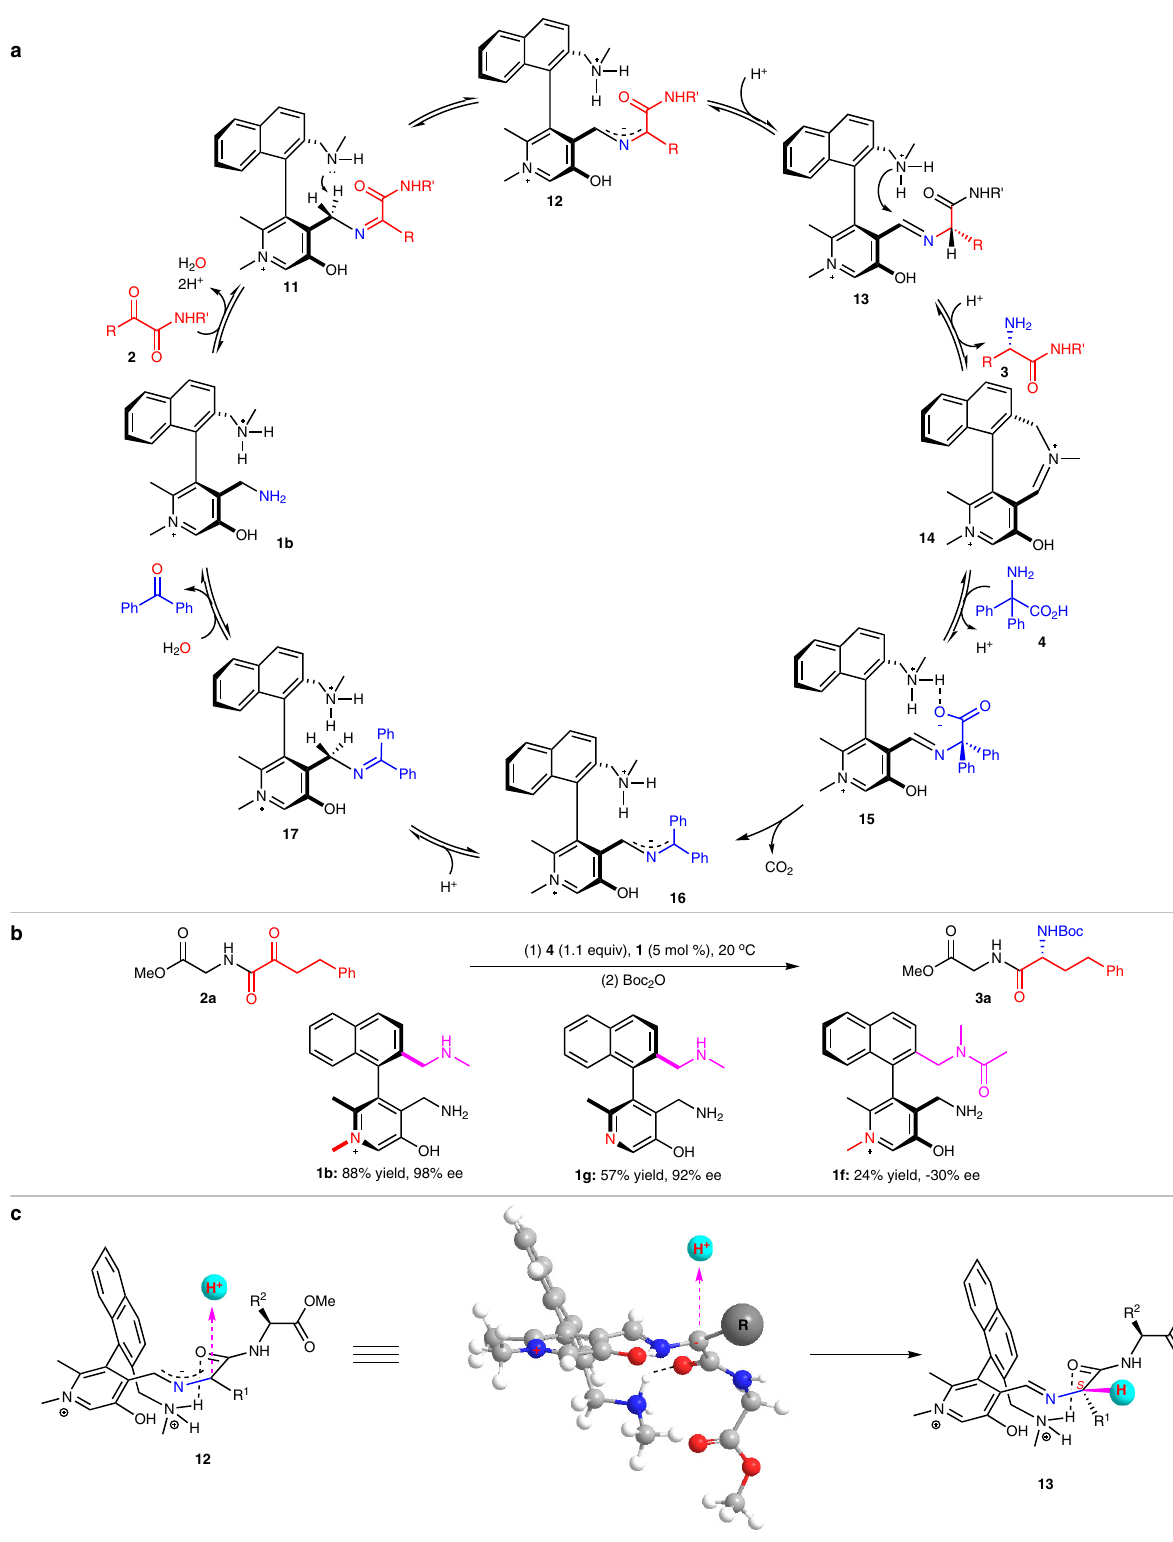
Fig. 6 Reaction mechanism. a Proposed reaction pathway. b Comparison of catalysts. c Proposed transition state for the asymmetric 1,3-proton